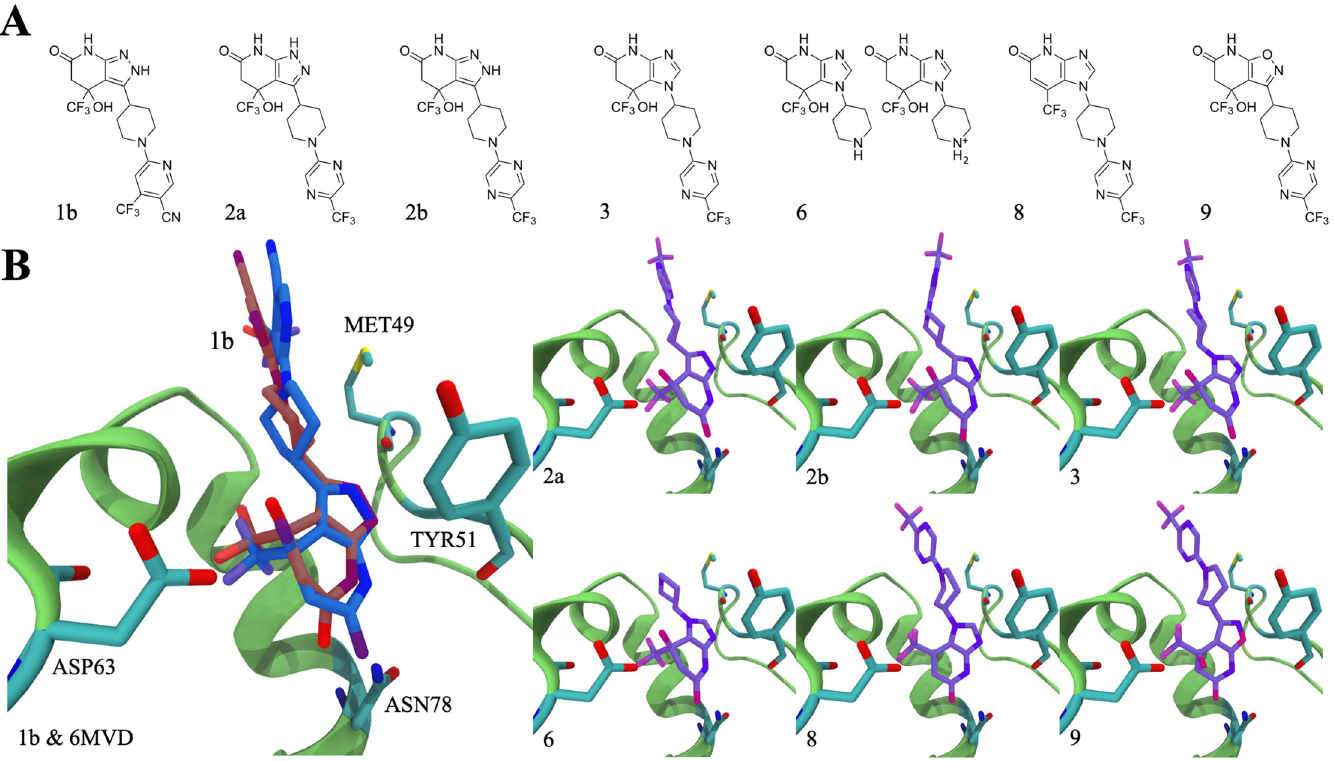
Fig 2. (A) The chemical structures of the compounds studied. (B) The docking poses of the compounds bound (hued purple) in the MBD cleft of LCAT and the co- crystallized compound 1b (PDB accession code 6MVD; hued blue) compared to its position docked back the structure (hued red). The allosteric site of LCAT is rendered as a cartoon secondary structure representation and shown as green. The compounds and the significant amino acids are rendered as sticks and are colored according to different elements. Carbon atoms are cyan, oxygen red, nitrogen blue, fluorine pink, and sulfur